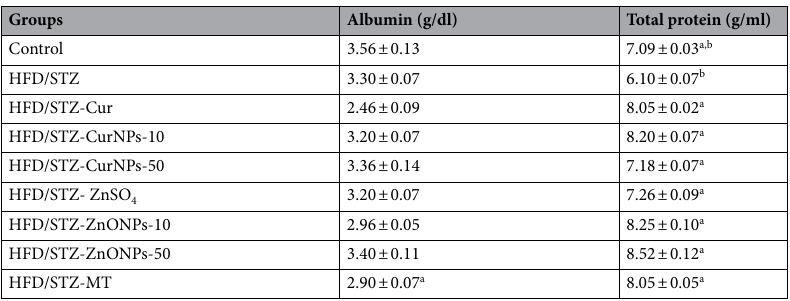
Table 5. Effect of CurNPs and ZnONPs administration on serum liver proteins (albumin and total protein) of STZ-induced diabetic and control rats. Values are expressed as mean ± SEM (n = 7), means for the same parameter with different letters in each column are significantly different (Tukey, p < 0.01).